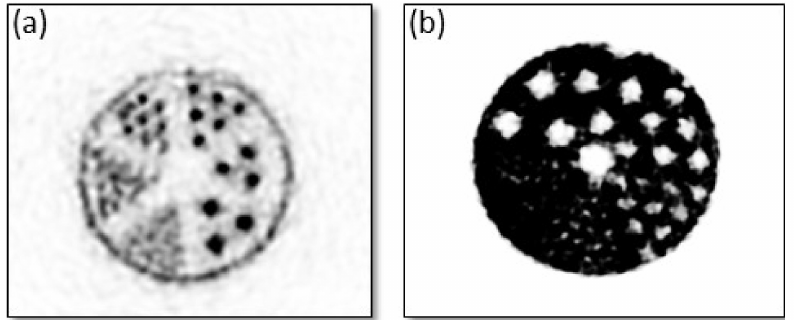
Figure 5. The transverse PET images of mouse and rat-like Derenzo phantoms. ( a ) Mouse-sized hot rod image and ( b ) rat-sized cold rod image.